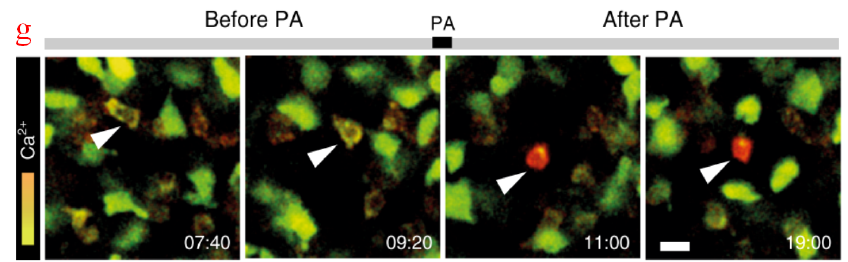
Figure 7. Tracking methods of manipulation tools and targeted specimens. ( a ) Micropipette tracking based on a motion history image where the red region illustrates the motion history of the end-effectors and arrows show its motion gradient. Adapted with permission from Reference [136]; ( b ) Micropipette tracking based on the reinitialization and recovery mechanism. The micropipette tip is tracked using a predefined template before cell occlusion. After that, the Relock mechanism is activated to track the micropipette tip with the updated template during cell interaction. Adapted with permission from Reference [137]; ( c ) Sperms tracked with the modified joint probabilistic data association filter method. Adapted with permission from Reference [139]; ( d ) Cell aspiration length tracking process, where the original sampled images were smoothed and separated into two ROI. The aspiration length was tracked with left ROI. Adapted with permission from Reference [143]; ( e ) Aspiration length tracking with CFM-sampled images. Adapted with permission from Reference [144]; ( f ) PAM imaging of a microbot in mouse vena cava. Adapted with permission from Reference [146]. ( g ) Activation and tracking of the calcium-mediated actuator inside mouse T-cells. White arrows indicate the targeted cell before and after photon activation. Adapted with permission from Reference [146].